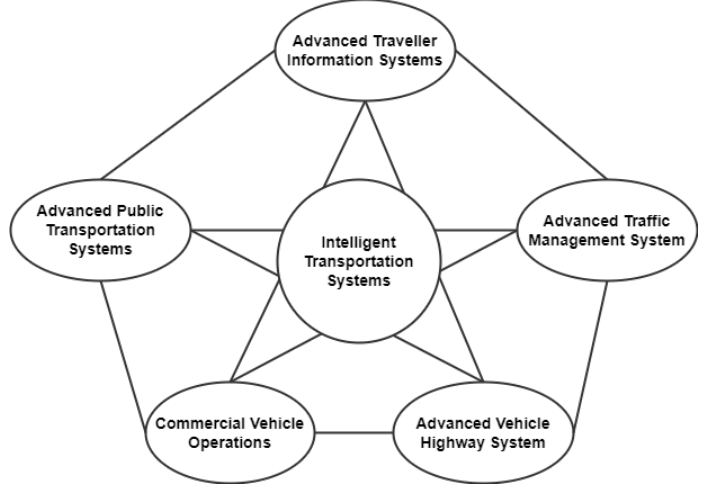
Figure 1. Schematic overview of ITS components